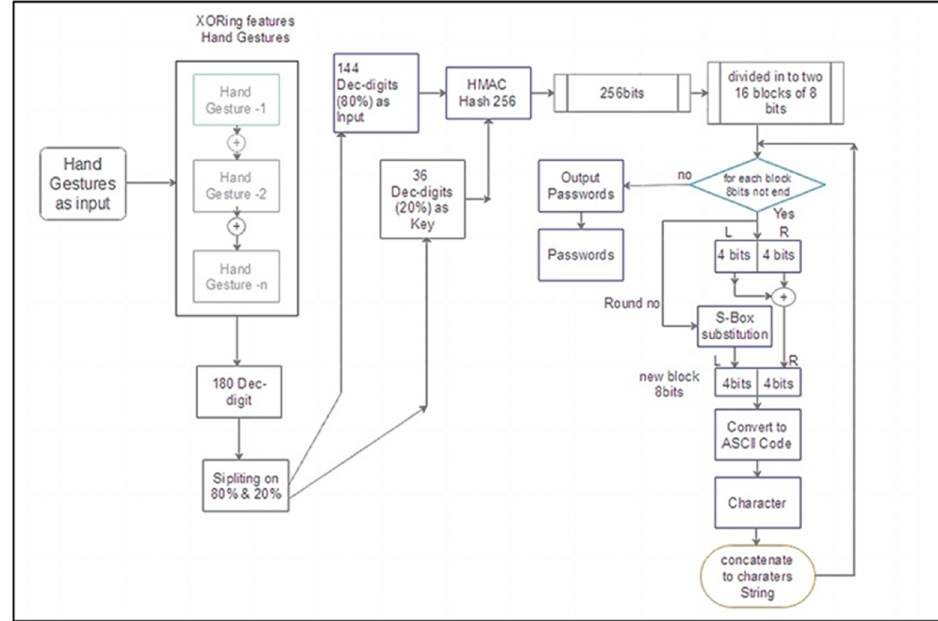
Figure 5. The proposed password generator.